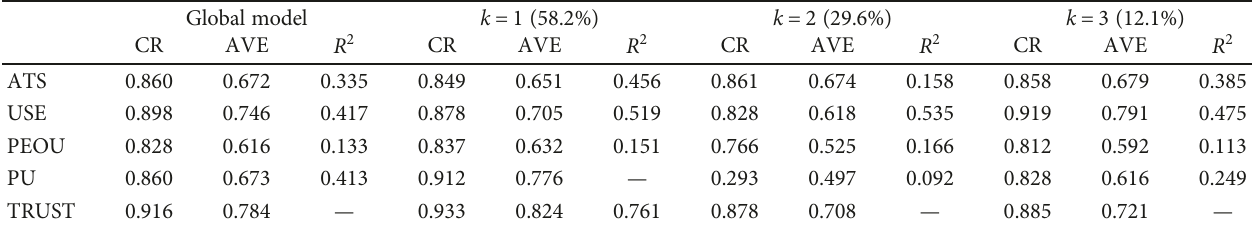
Table 12: Reliability measurements for the general model and for the three